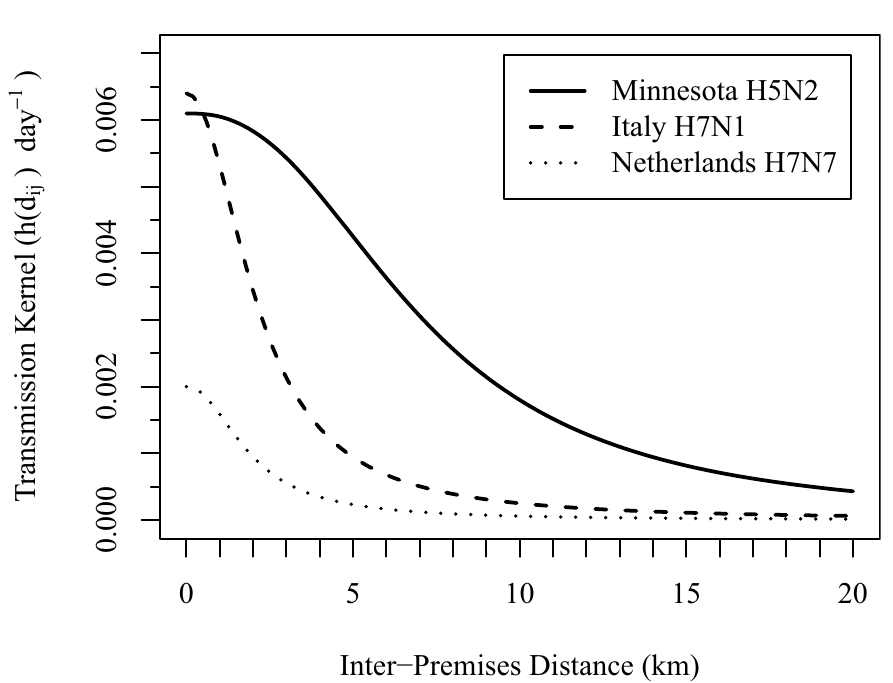
Fig 4. Minnesota, Italy, and Netherlands spatial transmission kernel comparison. Spatial transmission kernels evaluated across distance using the mean parameters estimated from the 2015 Minnesota HPAI H5N2 outbreak under the baseline scenario, the 1999–2000 Italy HPAI H7N1 outbreak under the Dorigatti, Mulatti (6) basic model scenario, and the 2003 Netherlands HPAI H7N7 outbreak under the Boender, Hagenaars (4) default scenario. Table 2 for the Minnesota, Dorigatti, Mulatti (6), and Boender, Hagenaars (4) transmission kernel estimates.